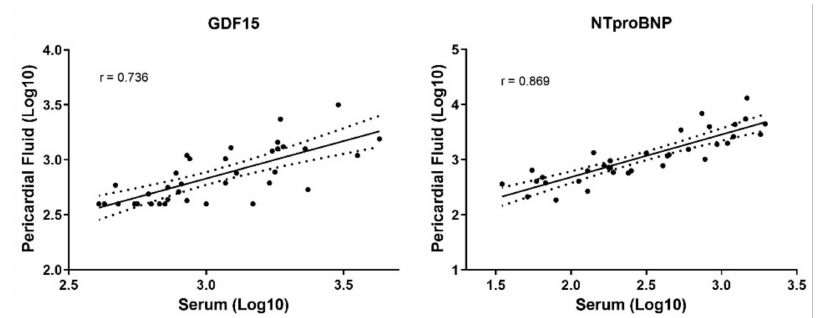
Figure 5. Correlation between serum and pericardial fluid quantifications of both GDF-15 and NT-pro-BNP biomarkers. Measure of association—–Pearson’s correlation